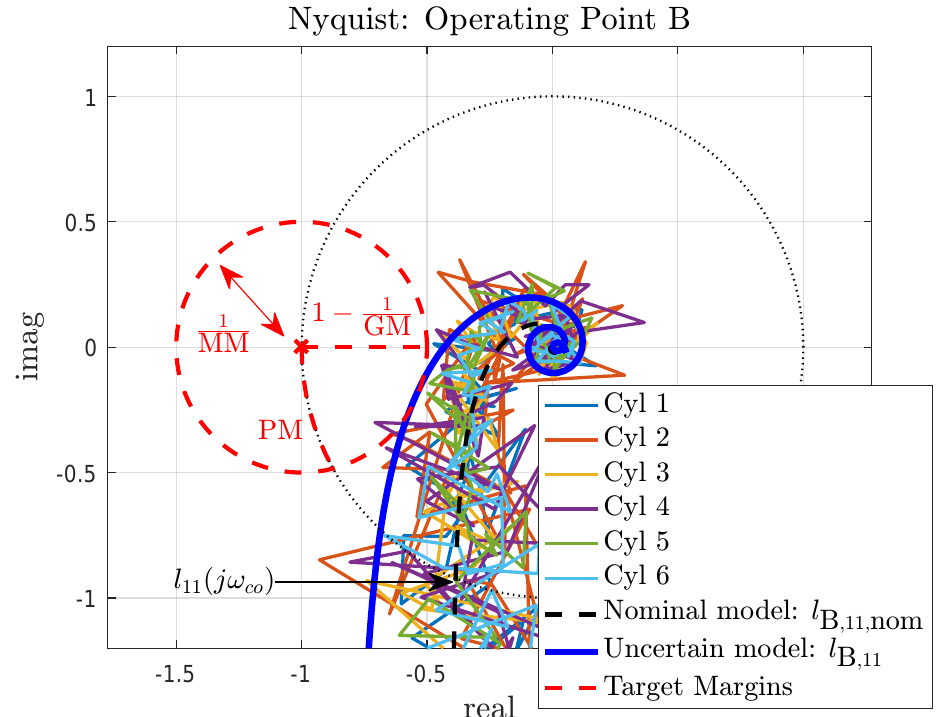
Figure A1. Nyquist plot of l B,11 for six individual cylinders (operating point B).